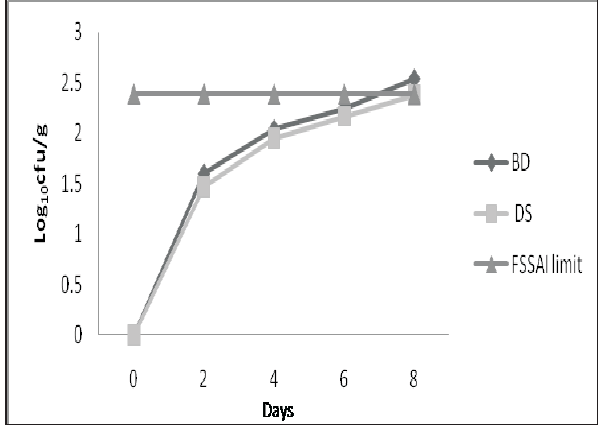
Figure-4: Yeast and mold counts in low cholesterol masala paneer